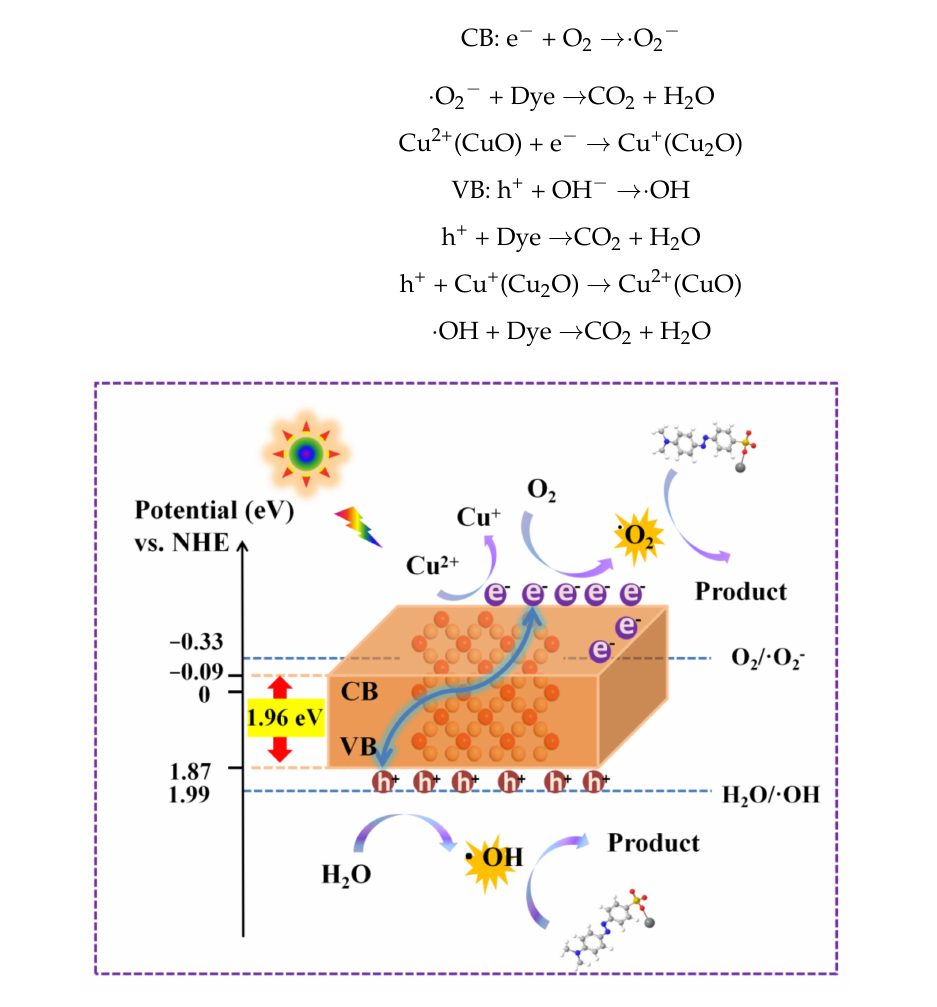
Figure 11. Schematic illustration of the MO degradation mechanism over Cu 2 O nanocrystals under visible